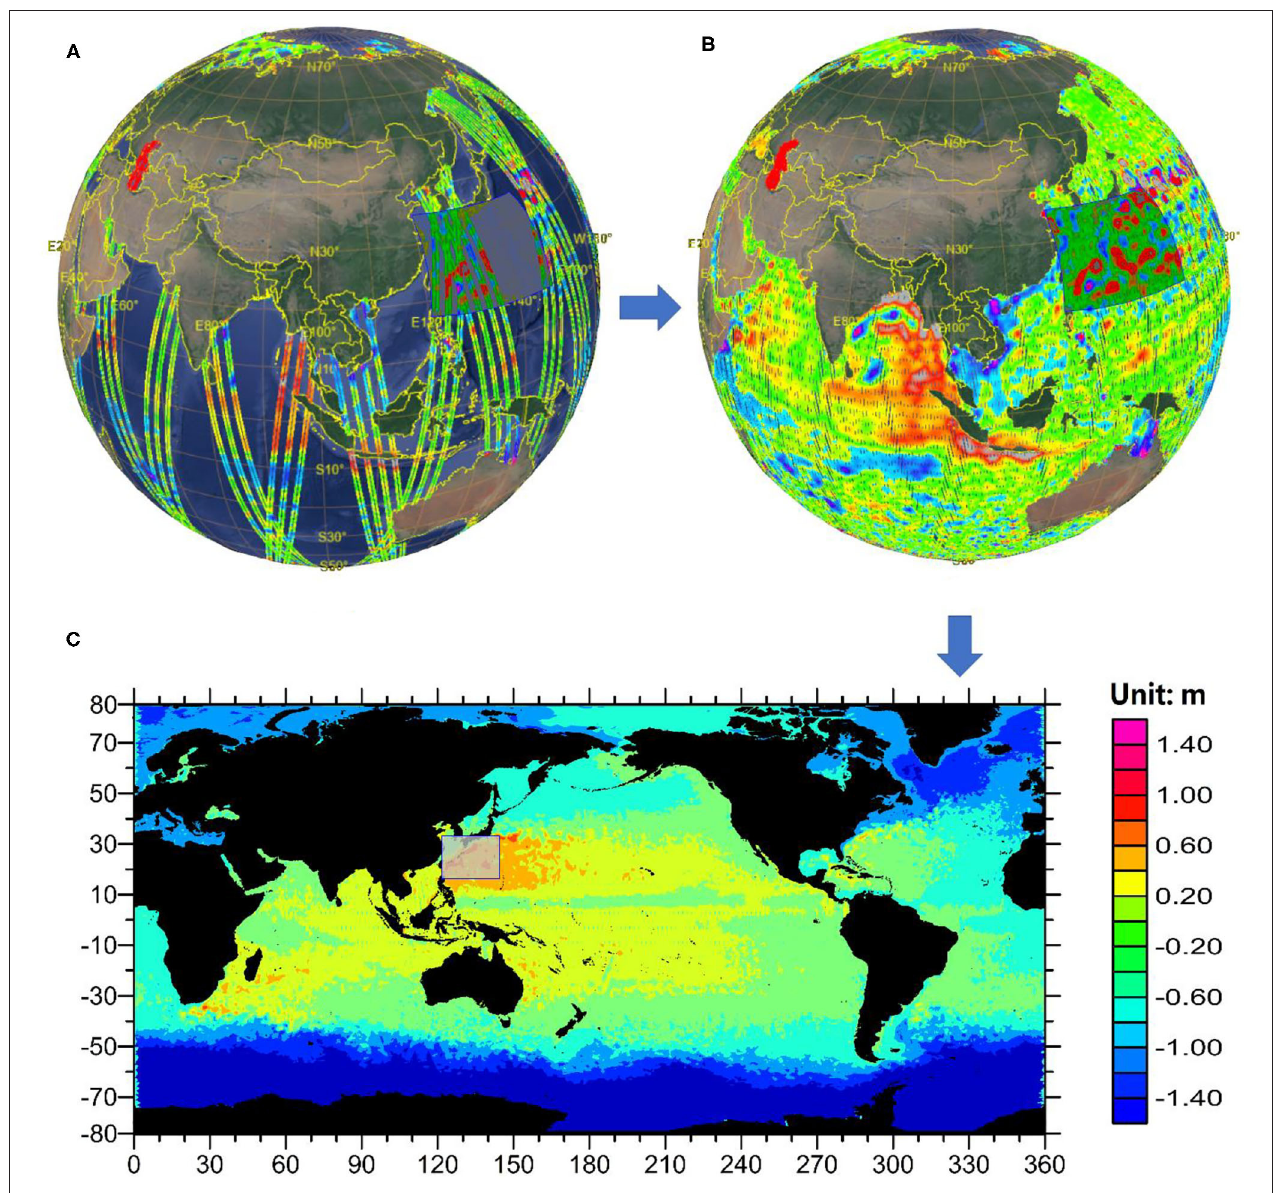
FIGURE 1 | (A) The example of along-track SSH data; (B) An example of one-cycle sampling simulation; (C) Obtained from the data projection of (B) onto a 2D